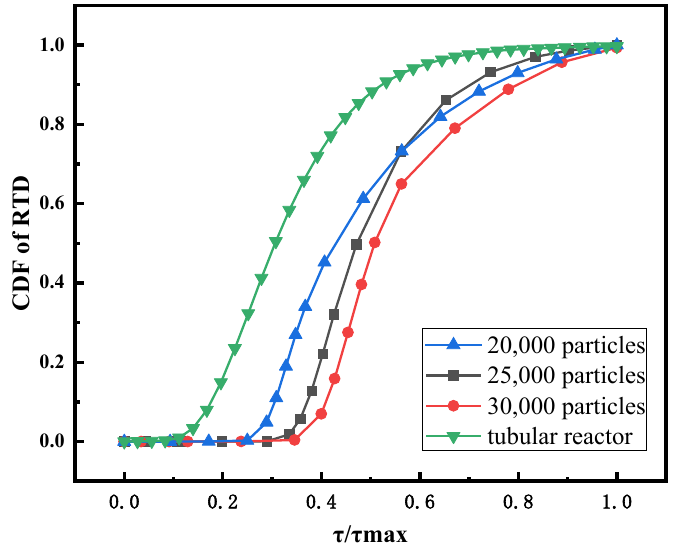
Figure 10. CDF of RTD for a tubular reactor and fluidized beds with different initial bed heights.